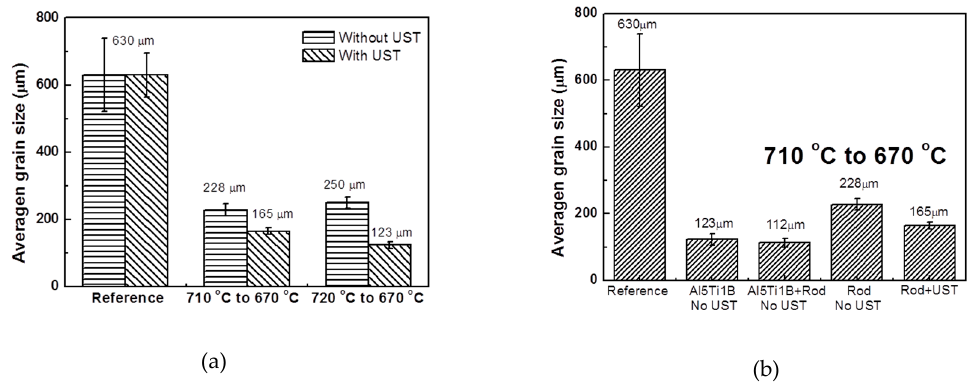
Figure 6. Grain sizes achieved in experiments: ( a ) the effects of the same-rod introduction, ultrasonic oscillations and the temperature range of introduction and ( b ) comparison of the same-alloy rod introduction with the standard grain refinement by master alloy addition.